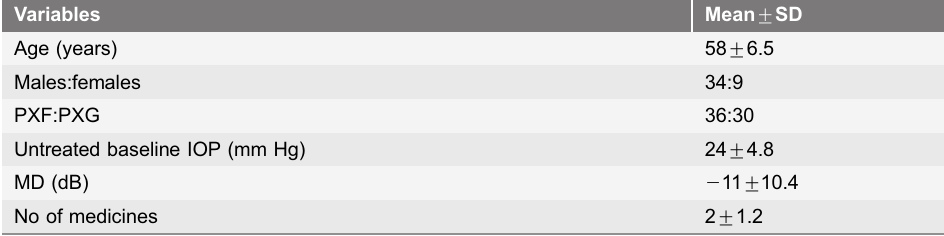
Table 1. Demographic and clinical characteristics of patients with bilateral pseudoexfoliation syndrome.